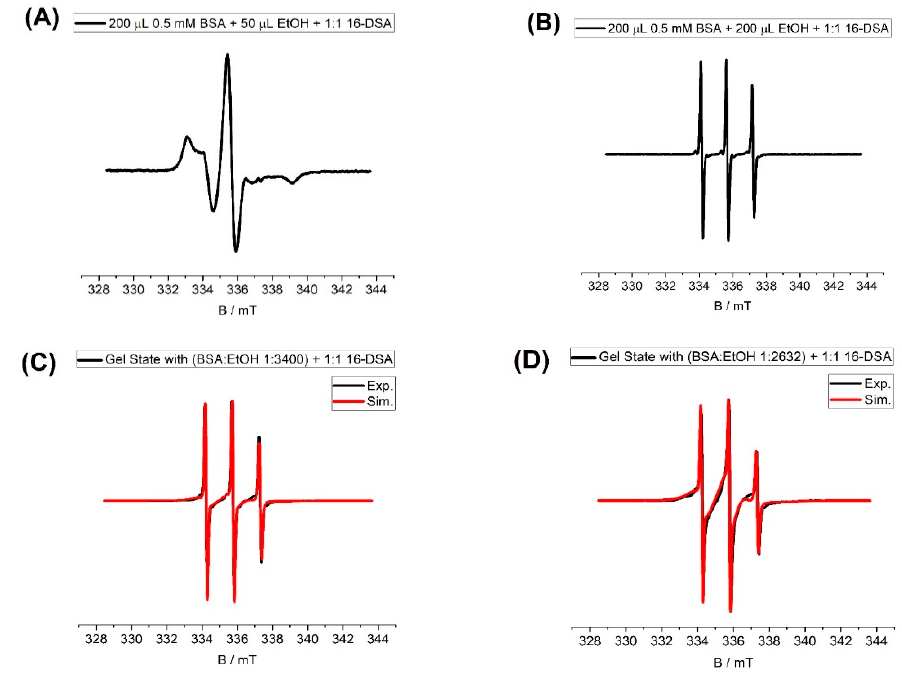
Figure 4. The samples are prepared based on Table A2. Electron paramagnetic resonance (EPR) spectra of ( A ) and ( B ) shows that the addition of ethanol dramatically weakens the interaction between protein and stearic acid. The data for ( C ) and ( D ) and Figure A4 are shown in Table 2.